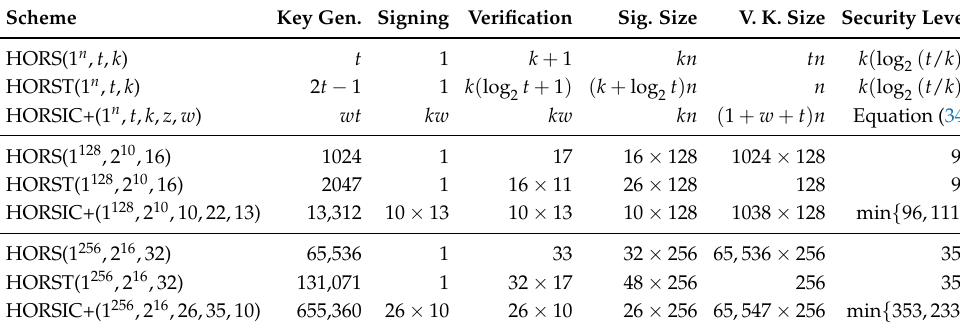
Figure 3. Normalized security level of HORSIC+ and HORS/HORST for multiple messages. Table 2. Comparison of HORS, HORST, and